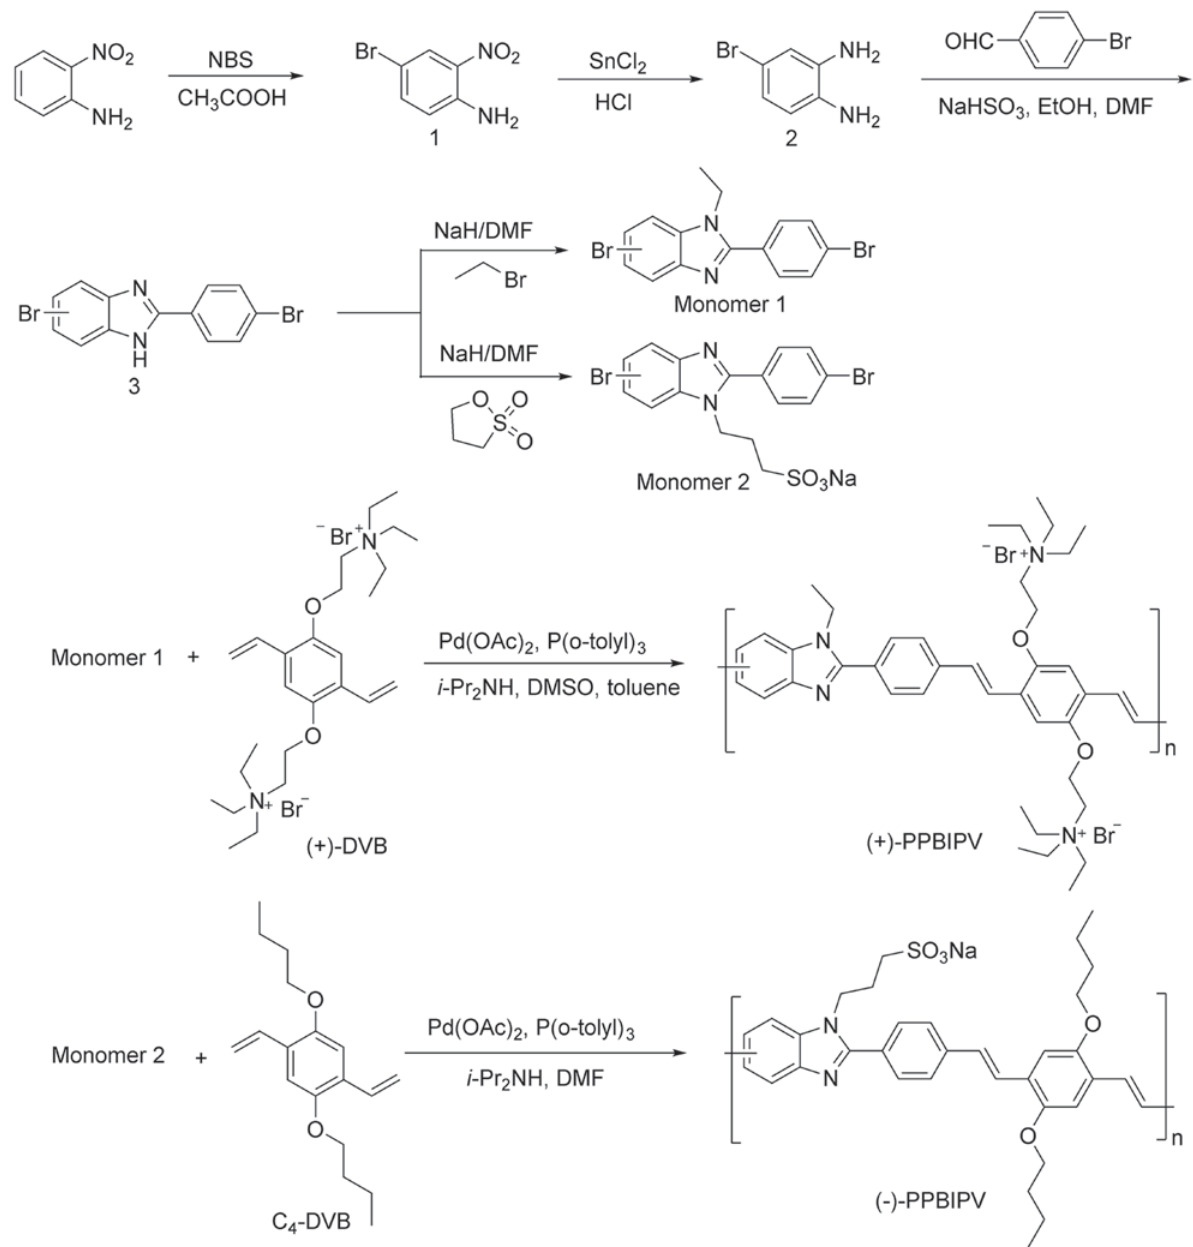
Scheme 1: Synthetic routes of monomers and